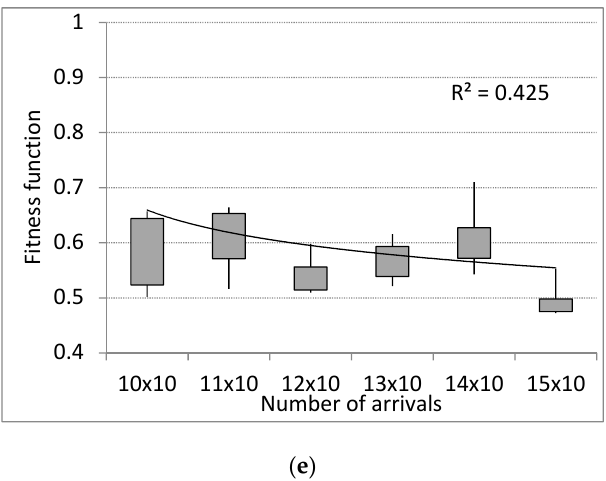
Figure 20. The influence of arrival intensity on ( a ) makespan, ( b ) cost of energy consumption, ( c ) cost of tardiness or premature execution, ( d ) total delay of tasks, ( e ) scalar fitness function for parallel flow.